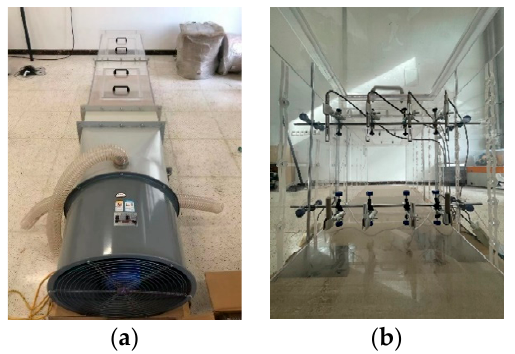
Figure 5. Device picture and sensor layout. ( a ) Real picture of test device; ( b ) layout of sensors inside the device.